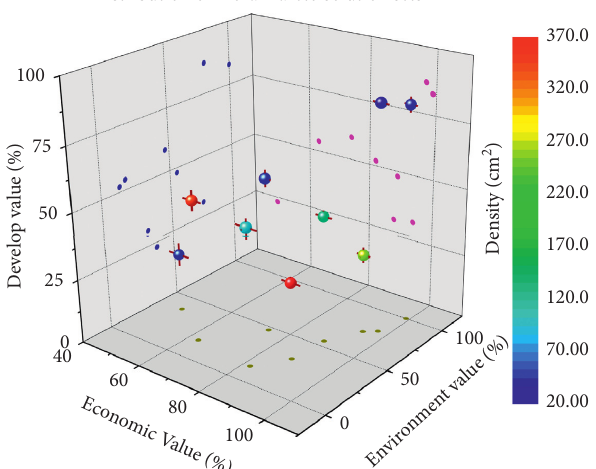
Figure 6: Distribution of moral Pareto solution sets for adaptive decreasing search with inertia